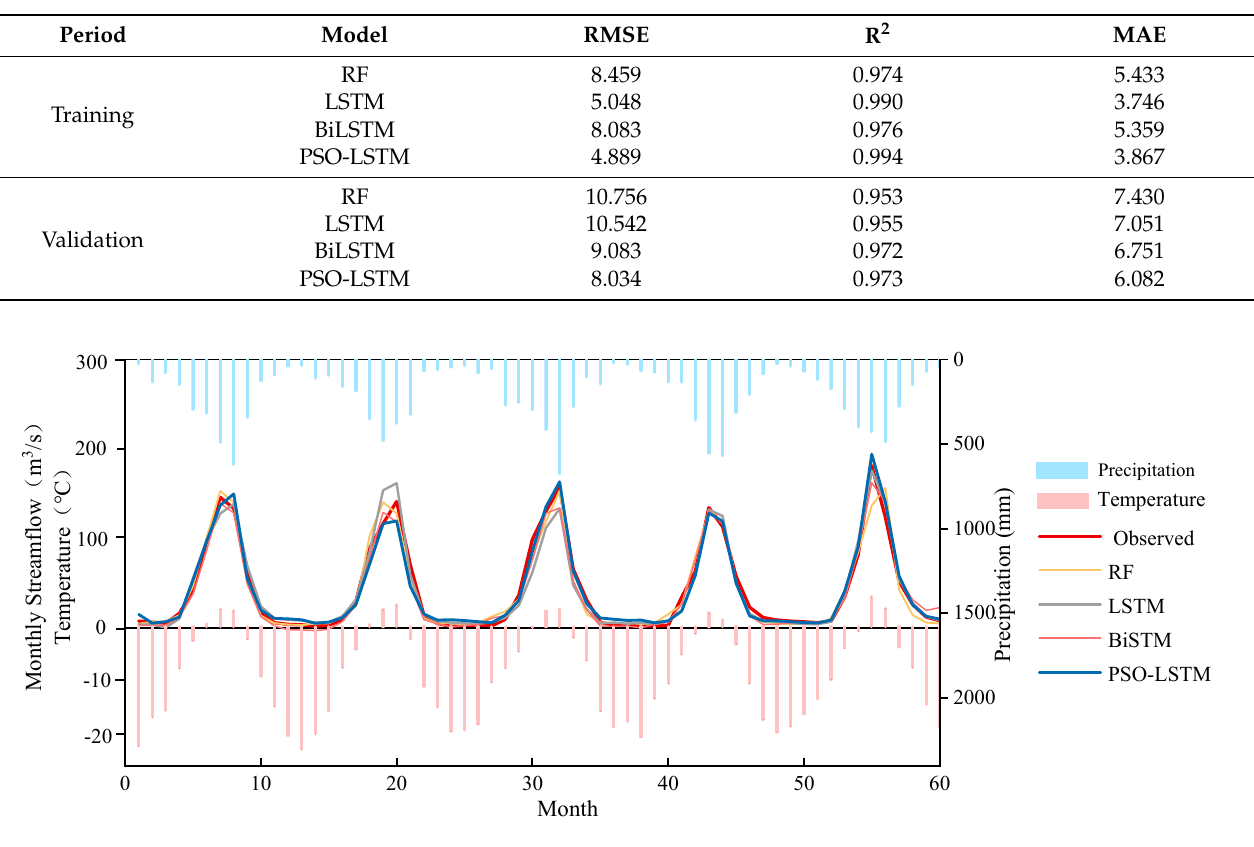
Figure 7. Simulation results of monthly average runoff processes during the test period.